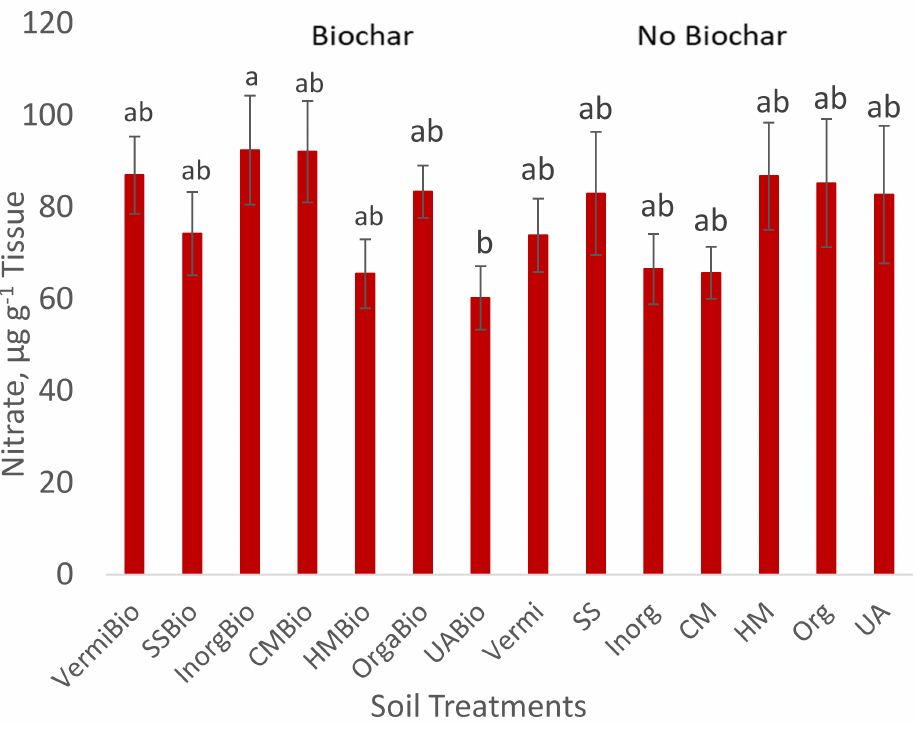
Figure 7. Concentrations of nitrate in turnip plants grown in seven soil treatments not amended with biochar (vermicompost Vermi, sewage sludge SS, inorganic fertilizer Inorg, chicken manure, CM, horse manure HM, organic fertilizer Org, and unamended UA control soil), and seven soil treatments amended with biochar (VermiBio, SSBio, InorgBio, CMBio, HMBio, OrgBio, UABio), regardless of turnip varieties. Statistical analysis was carried out among 14 soil treatments using analysis of variance (ANOVA). Standard errors having different letter(s) indicate significant differences ( p ≤ 0.05) using Duncan’s multiple range test for means